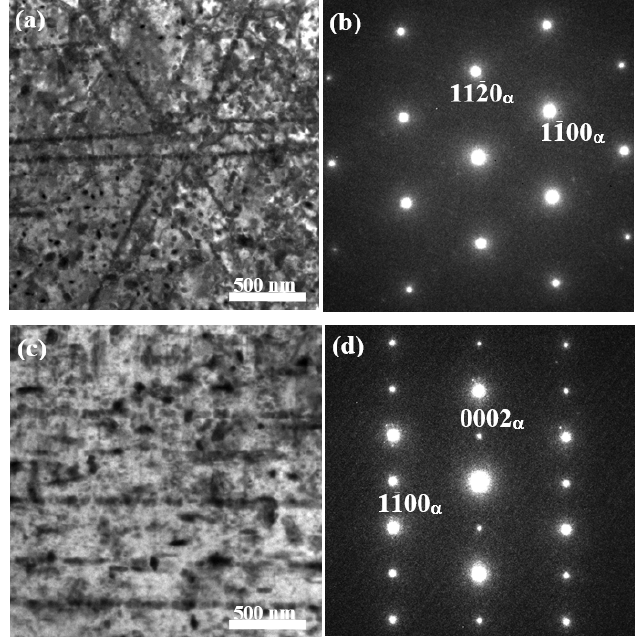
Figure 4. TEM micrographs showing the precipitate microstructures of the aged TZA442 alloy: ( a ) bright-field image obtained at the [0 0 0 1] α zone axis and ( b ) the corresponding diffraction pattern; ( c ) bright-field image obtained at a <1 1 2 0> α zone axis and ( d ) the corresponding diffraction pattern. ‘α’ in the lower right of the index indicate the α-Mg matrix.